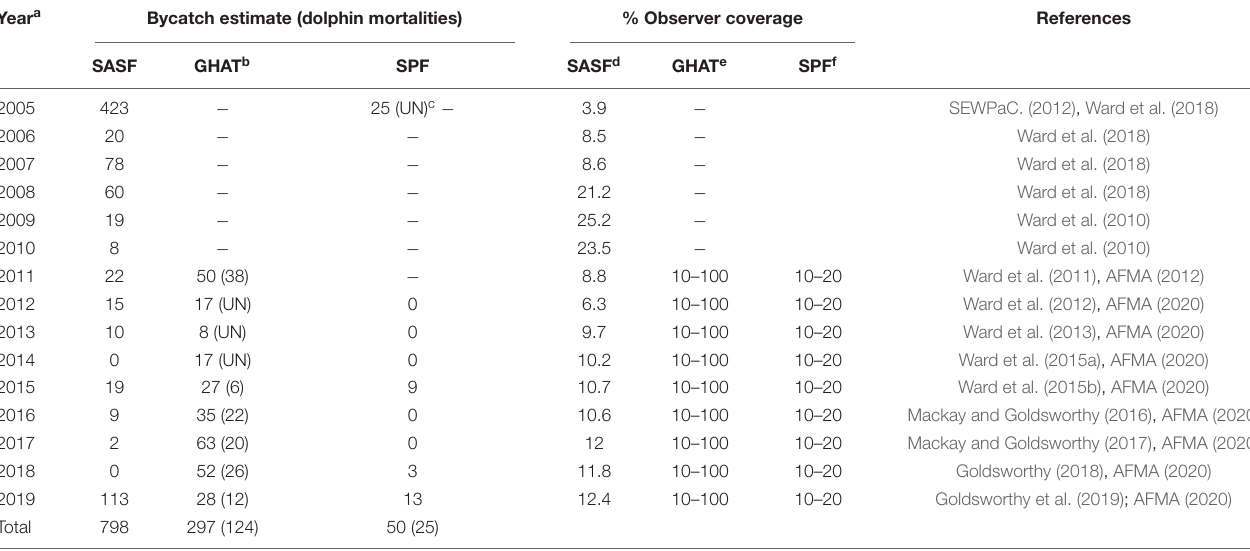
TABLE 1 | Annual bycatch estimates of common dolphins ( Delphinus delphis ) from observer programs in the South Australian Sardine Fishery (SASF), the Gillnet Hook and Trap (GHAT) sector of the Southern and Eastern Scalefish and Shark Fishery and the mid-water trawl sector of the Small Pelagic Fishery (SPF) off southern Australia. Year a Bycatch estimate (dolphin mortalities) % Observer